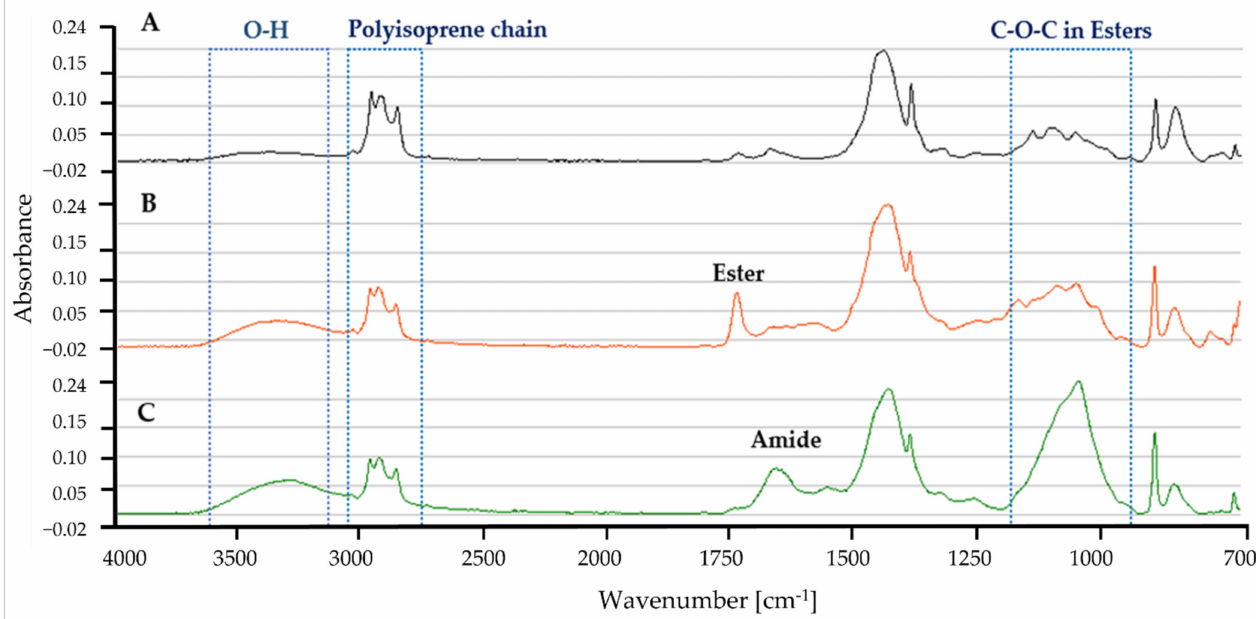
Figure 9. ATR-FTIR profile for latex glove strips as carbon source in MSM broth for 30 days, 28 ◦ C, 180 rpm ( A ) Control ( B ) Dactylosporangium sp. AC04546 ( C ) Microtetraspora sp.